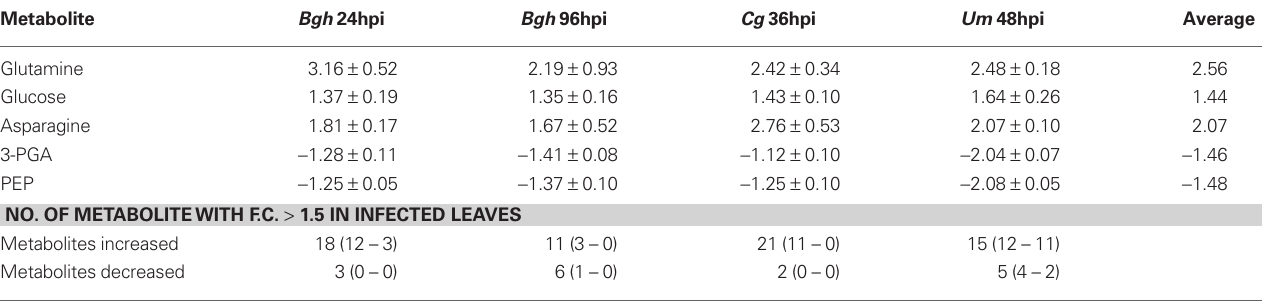
Table 1 | Metabolites consistently altered in all biotrophic